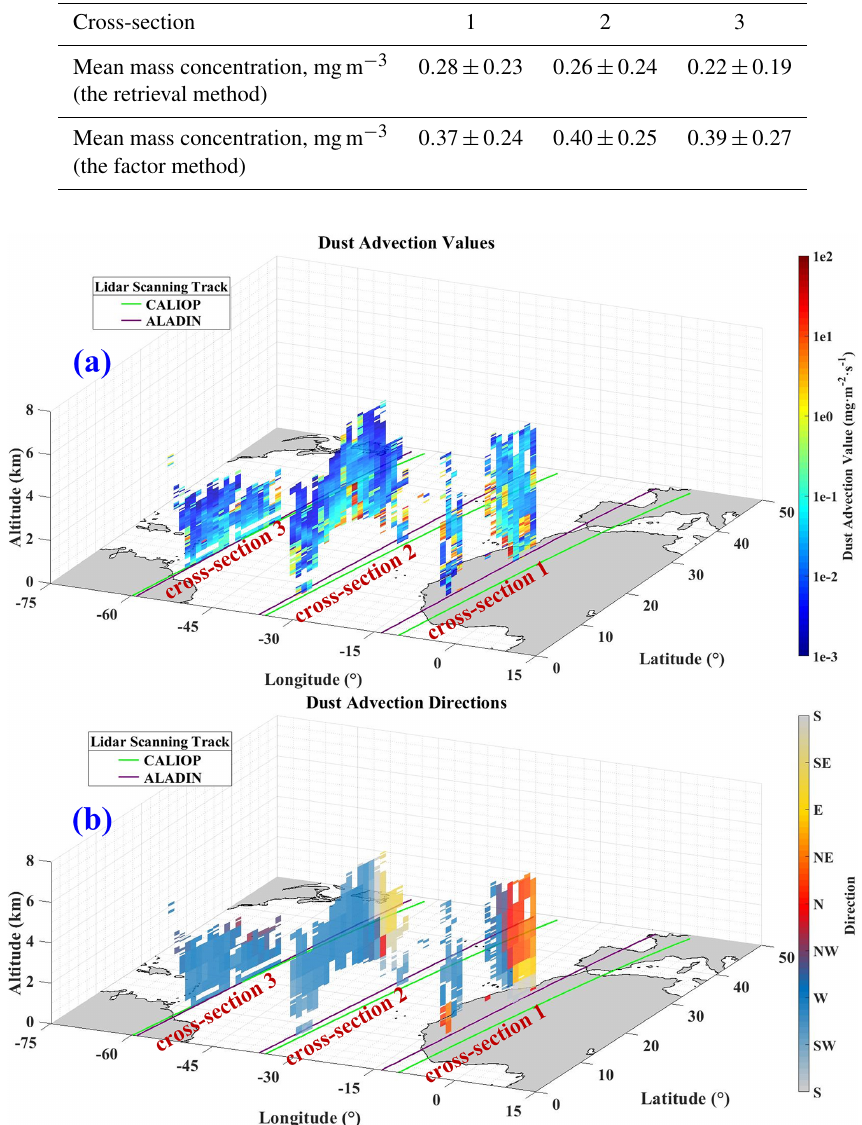
Figure 7. The dust advection calculated with data from ALADIN, CALIOP and ECMWF. (a) The dust advection values at different cross- sections of dust plumes and (b) the dust advection directions at different cross-sections of dust plumes on 19 June